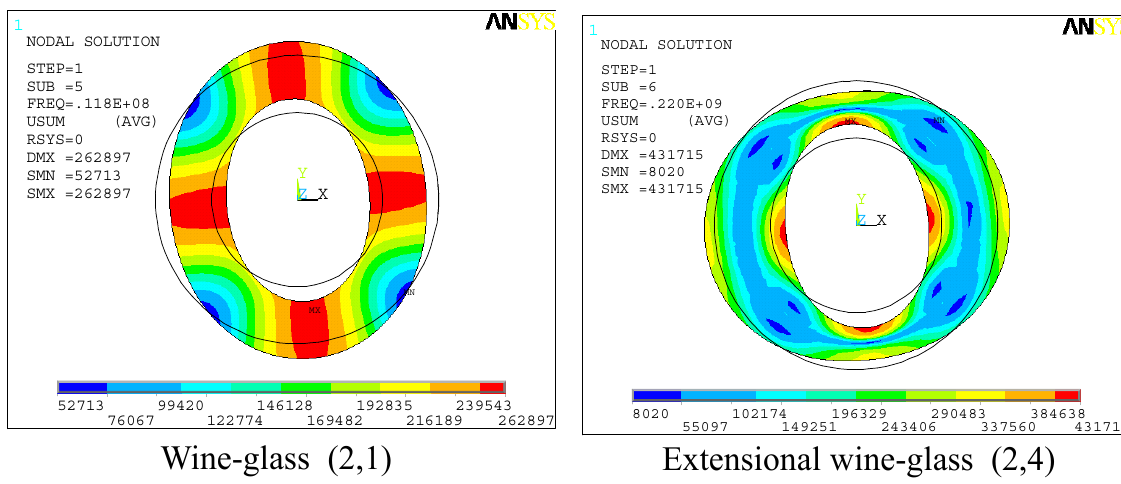
Figure 2. ANSYS simulation of the resonance frequencies for in-plane bulk-modes